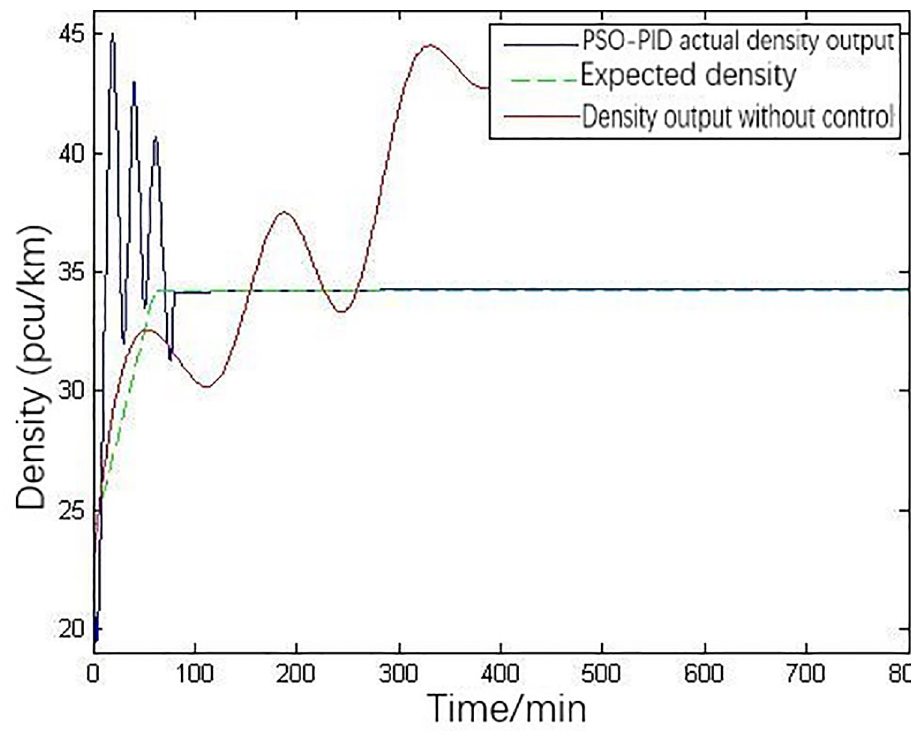
Fig 6. Density variation under PSO-PID